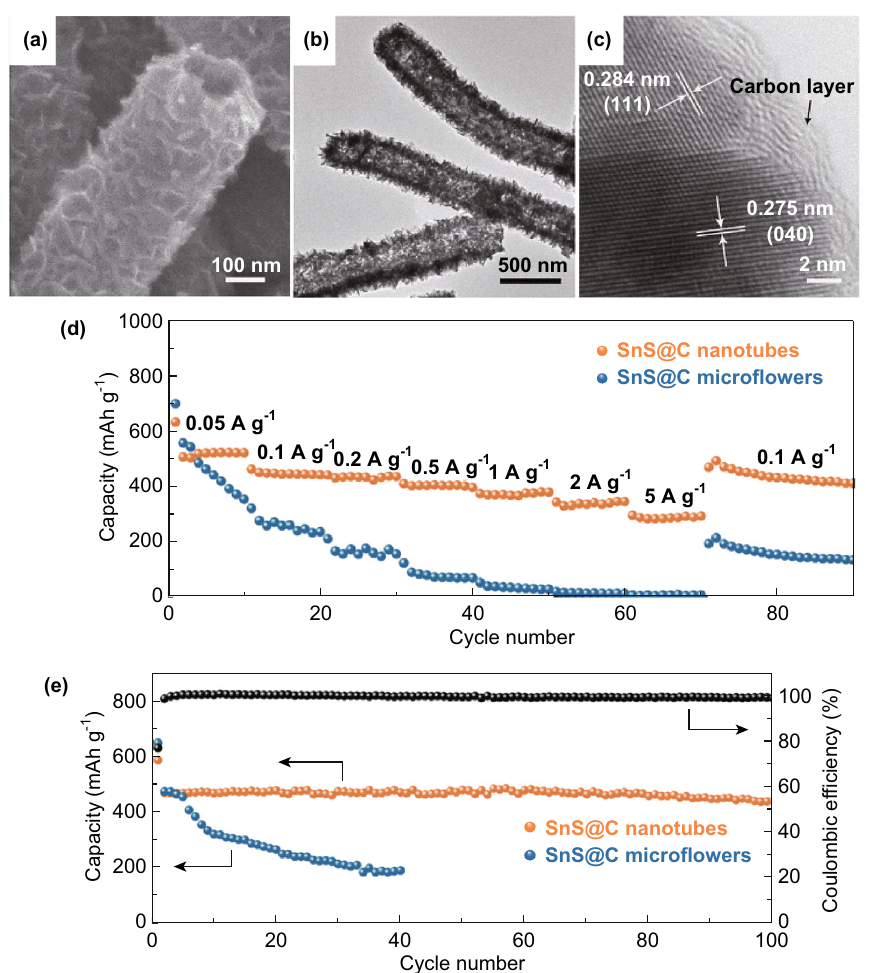
Fig. 13 3D architectures based on 2D ultrathin SnS nanoflakes on 1D carbon nanotube skeleton for SIBs. a FESEM and b TEM images of hierarchical SnS@C nanotubes. c HRTEM image of carbon-coated ultrathin SnS nanoflakes. d Rate performance of SnS@C nanotubes and microflowers. e Cycling performance of SnS@C nanotubes and microflowers at 0.2 A g - 1 , and Coulombic efficiency of SnS@C nanotubes during cycling. Reproduced with permission [133]. Copyright (cid:2) 2016, John Wiley & Sons,